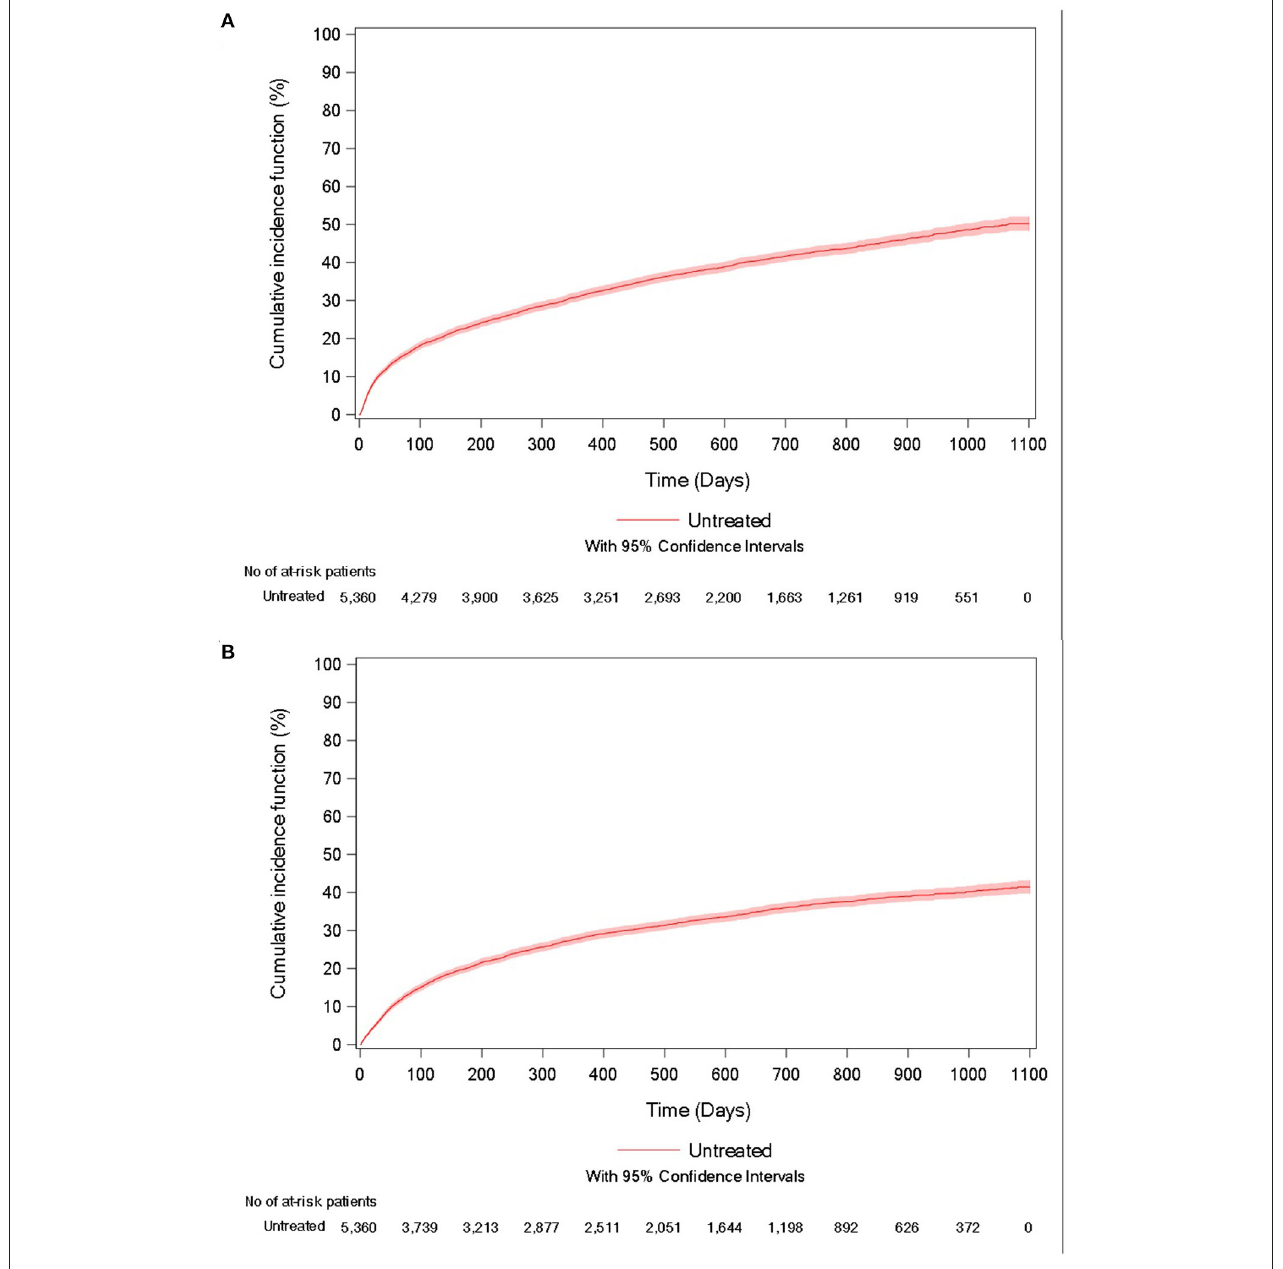
FIGURE 2 | Cumulative incidence curve of (A) all-cause mortality and (B) acute respiratory-related hospitalization for untreated IPF patients.